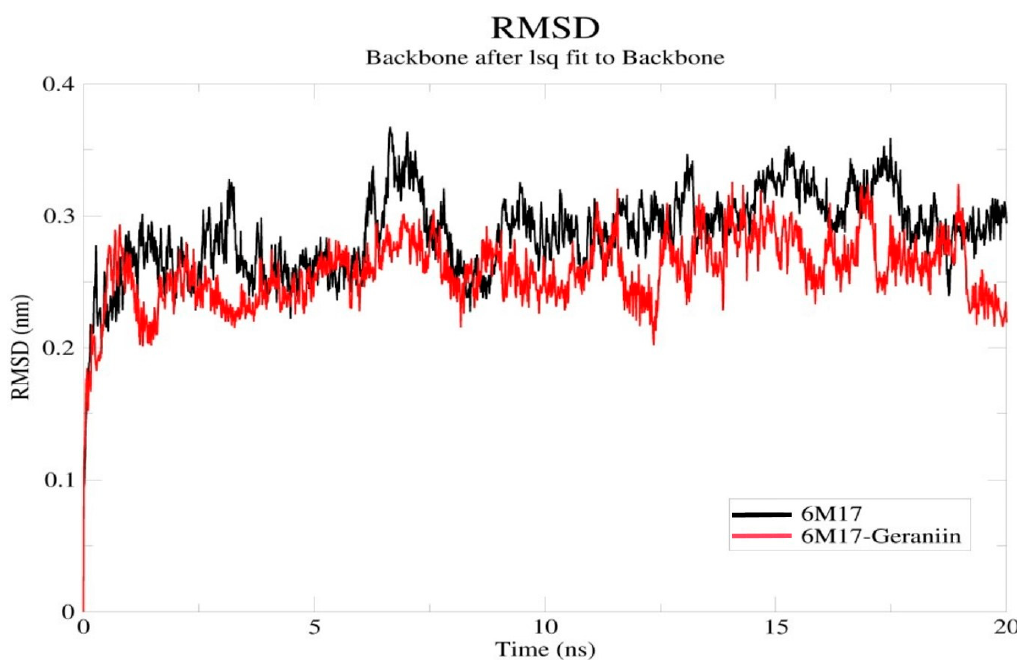
Figure 4. Backbone RMSDs of the apo 6M17 and 6M17–geraniin complex structures. RMSD Å (nm) is the ordinate, and time ns is the abscissa. The black and red lines indicate the 6M17 and 6M17–geraniin complex, respectively. (RMSD - Root Mean Square Deviation).